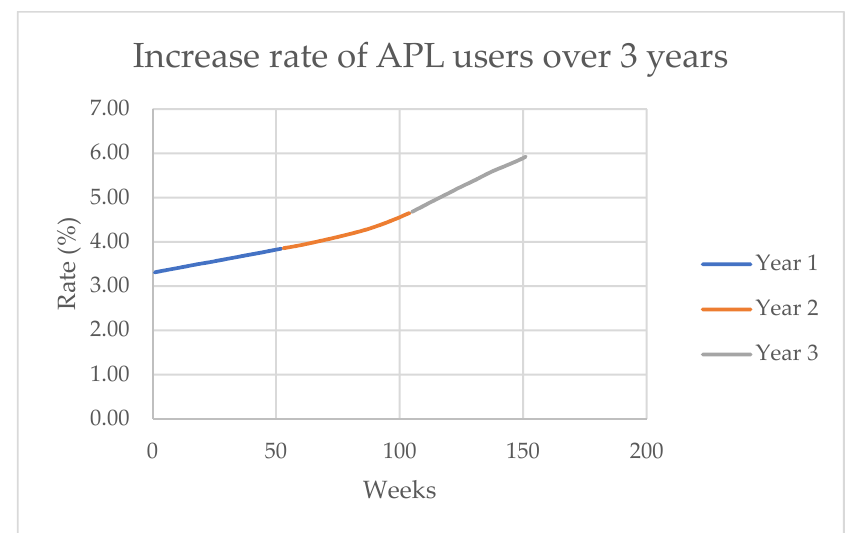
Figure 4. APL users evolution over 3 years.